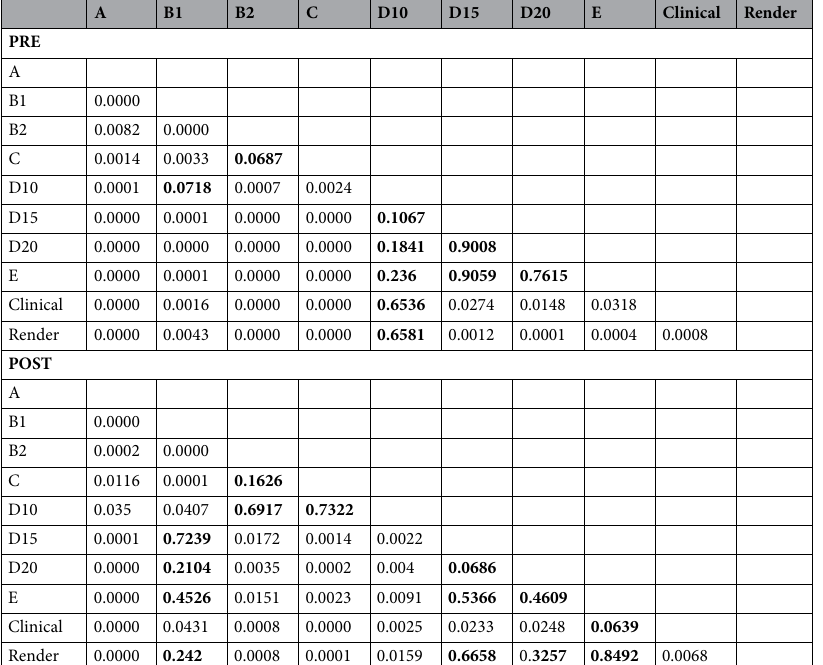
Table 2. p values for the statistically significant differences between the techniques (values not statistically significant in